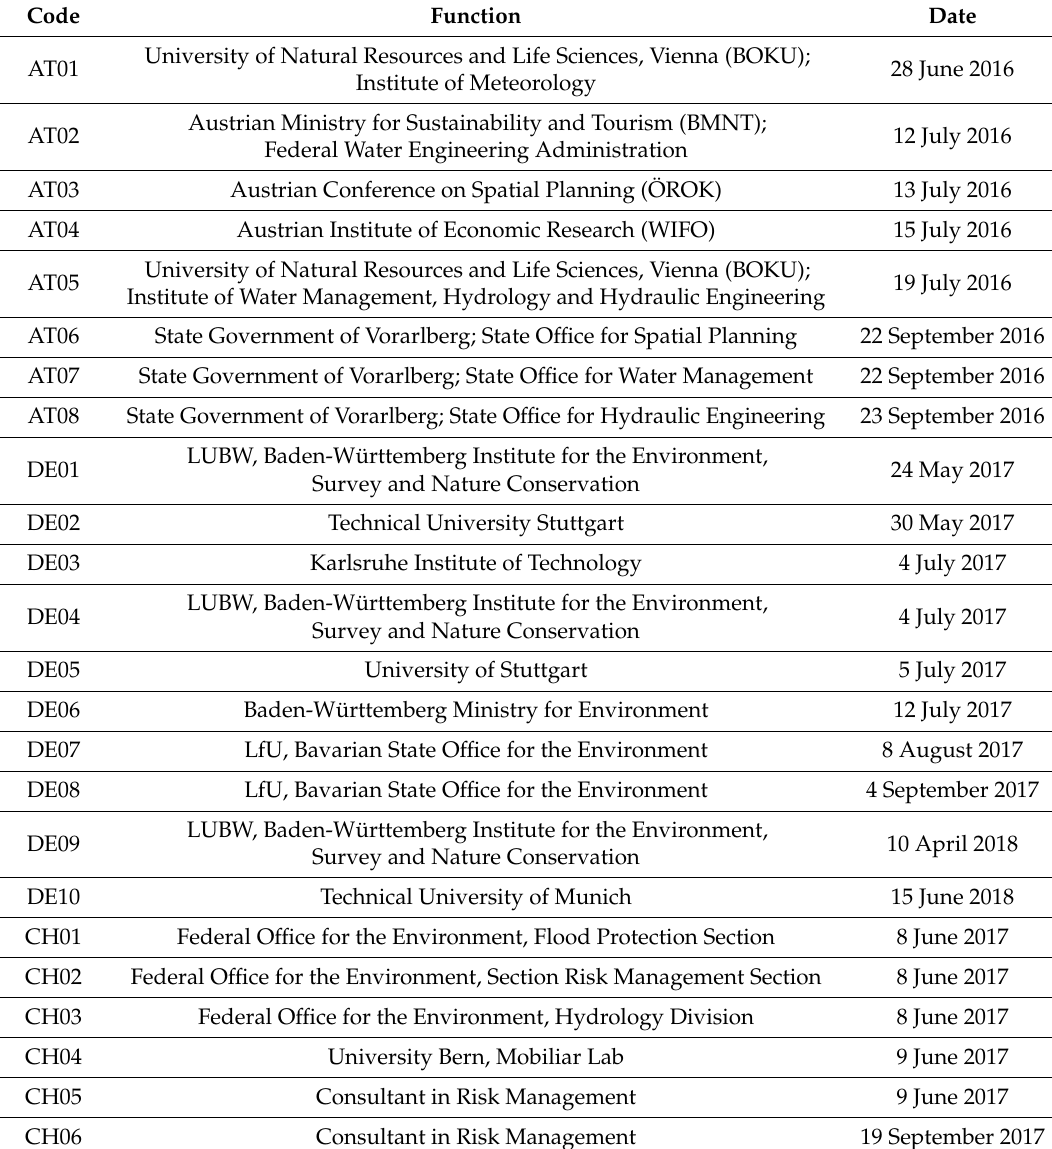
Table A1. List of expert interviews conducted in Austria, Germany and Switzerland. Code